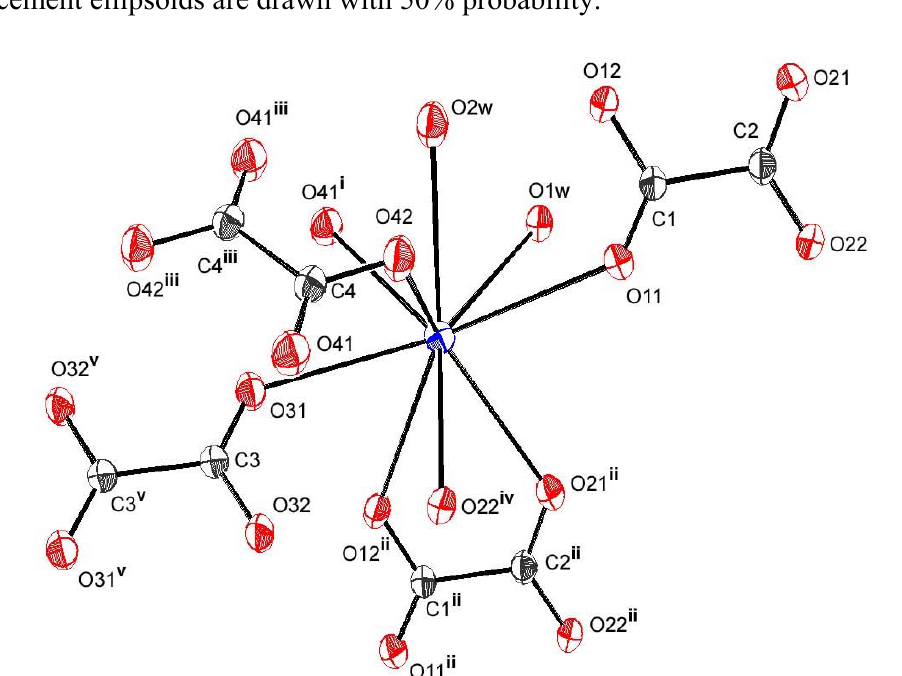
Figure 2. Ortep view showing asymmetric unit and Rb environnement in compound 1. Displacement ellipsoids are drawn with 50%